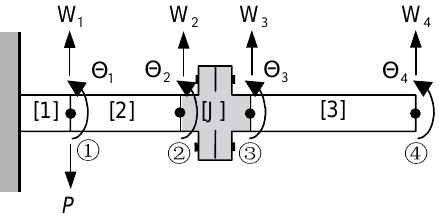
Fig. 4. Spectral element modeling for the beam structure with a